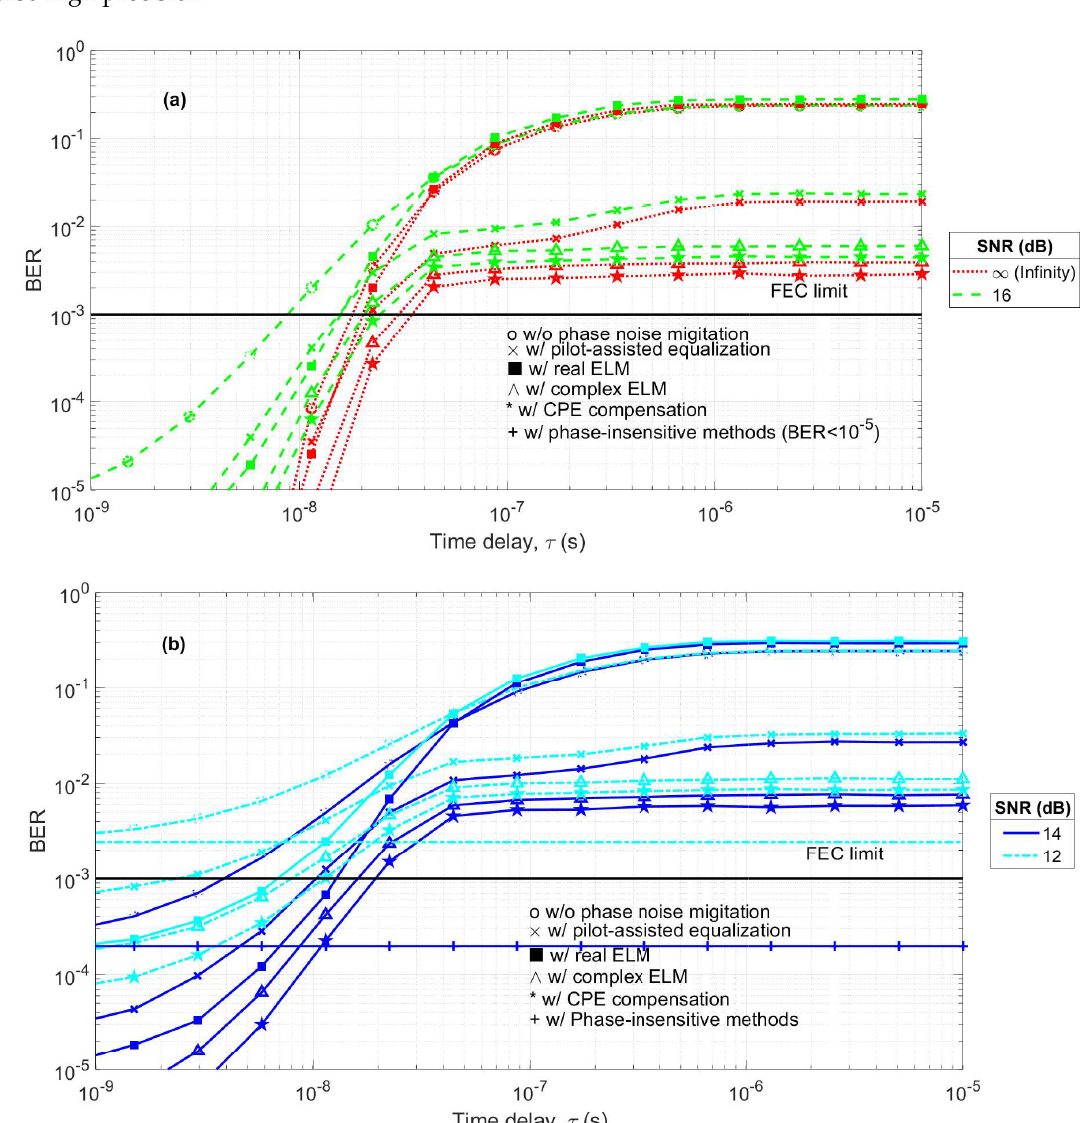
Figure 8. For diverse phase noise reduction techniques, the BER as a function of the decorrelation degree between the mixed tones with the SNR as the parameter and with a 0.5 MHz laser linewidth. This figure is divided into two to enable visibility. ( a) high SNRs; ( b) low